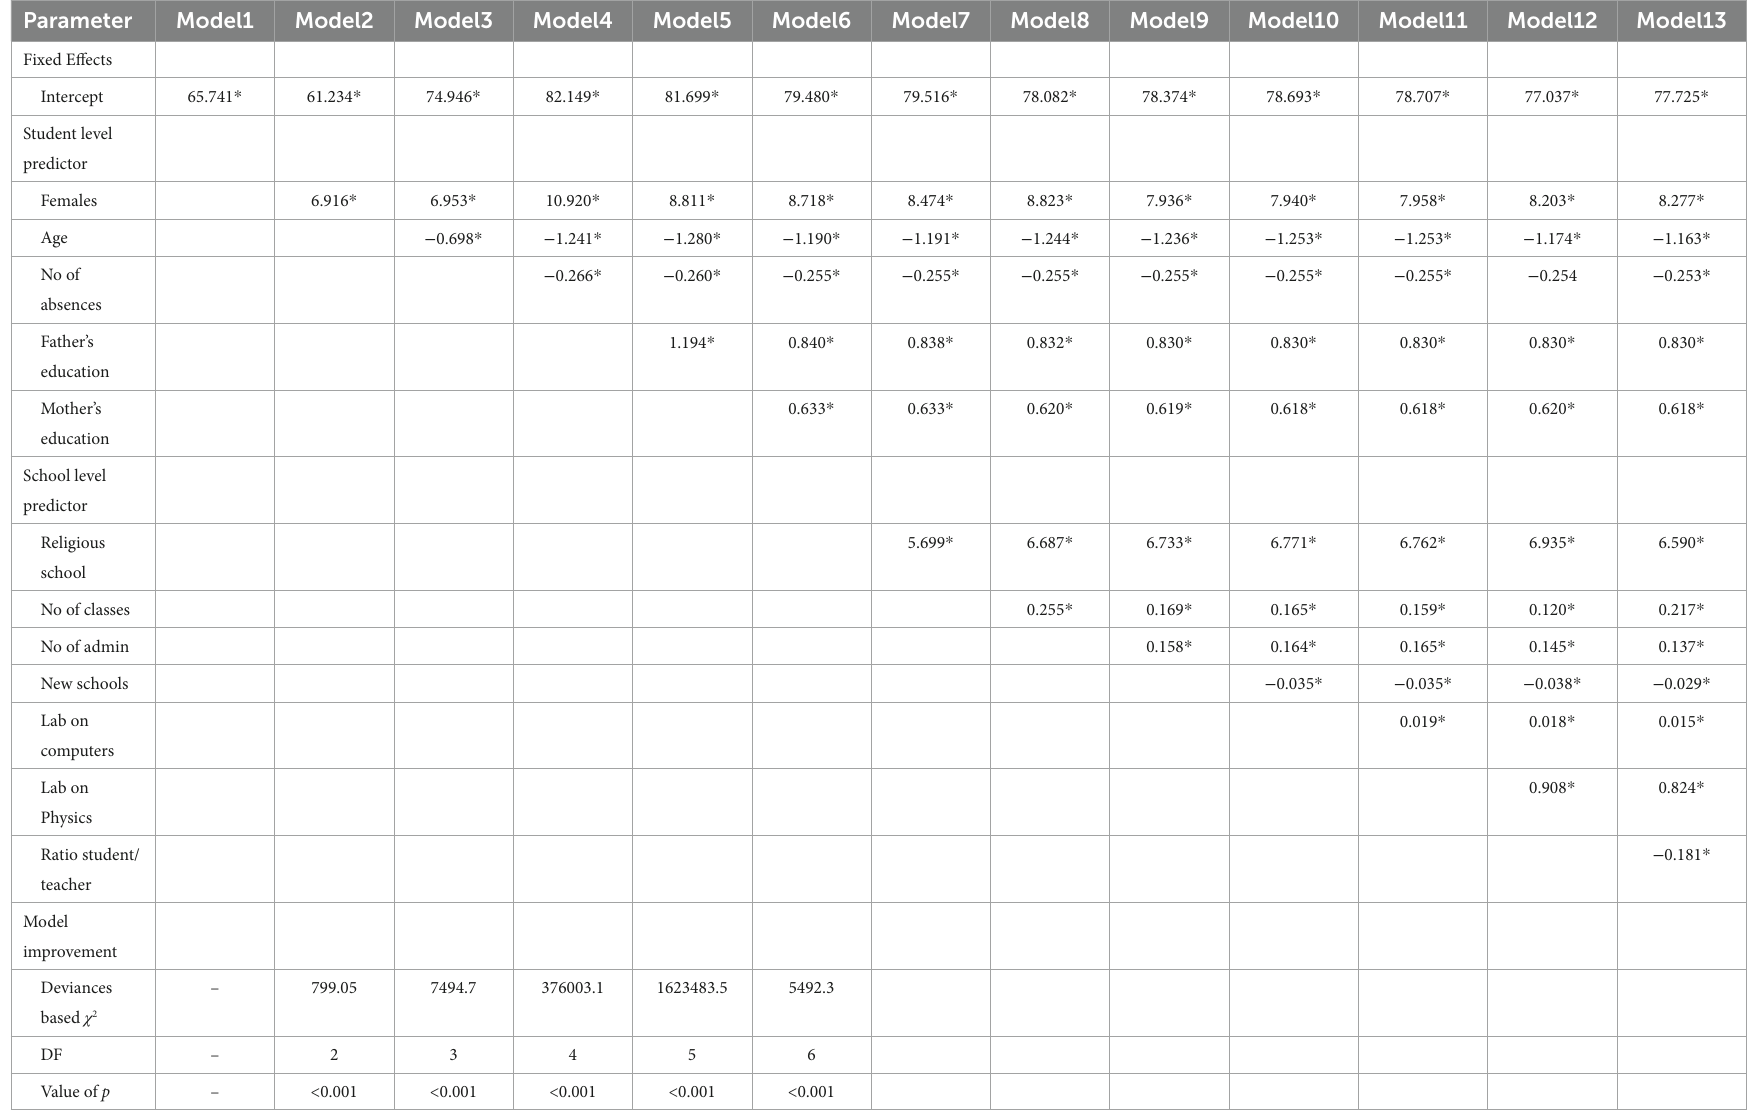
TABLE 3 High school achievement prediction from student level and school level